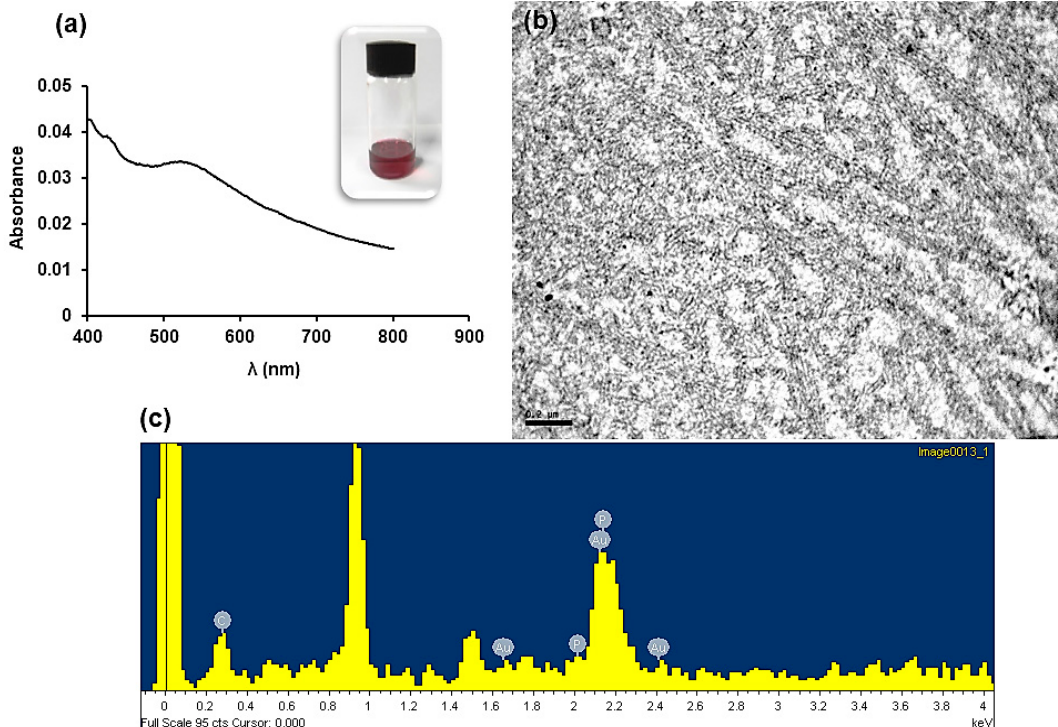
Figure 7. ( a ) UV / Vis absorption spectra and purple solution of cylindrical micelles of BCP 8a containing Au NPs. ( b ) Bright field TEM image of cylindrical micelles of 8a containing AuNPs (inset scale bar corresponds to 200 nm). ( c ) EDX analysis performed over the obtained cylindrical micelles.